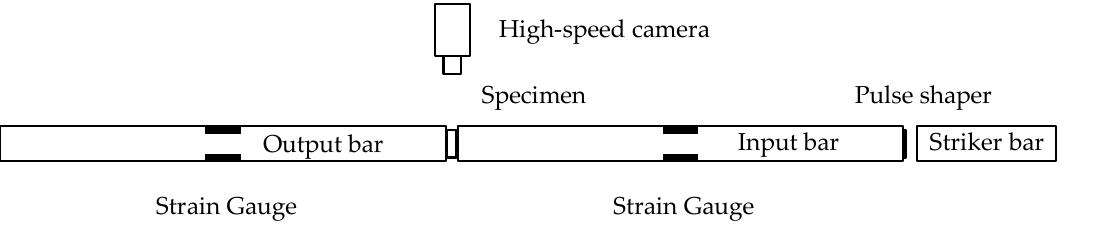
Figure 2. Schematic diagram of Split Hopkinson pressure bar (SHPB) experimental apparatus.